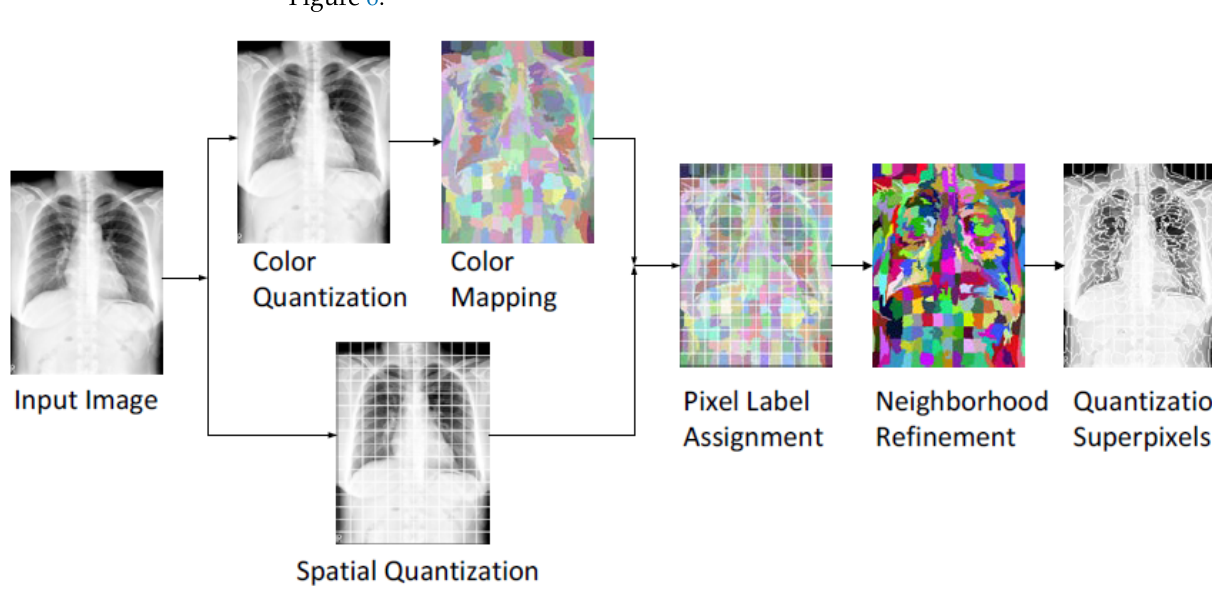
Figure 5. Flowchart of USEQ superpixel extraction method.